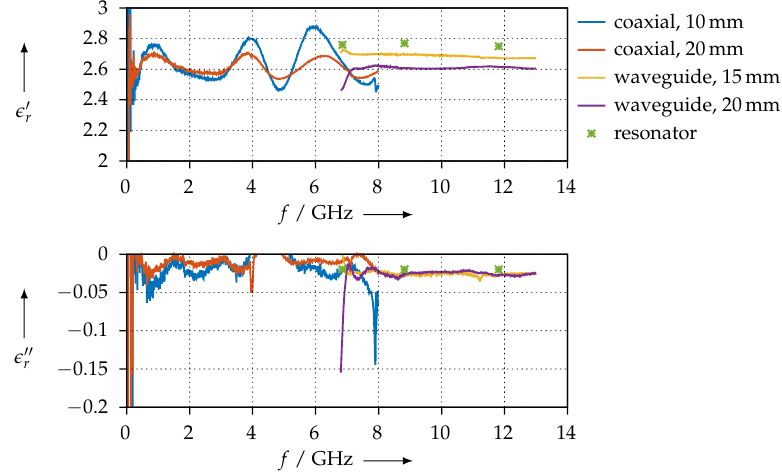
Figure 20. Real ( (cid:101) (cid:48) r ) and imaginary ( (cid:101) (cid:48)(cid:48) r ) parts of the permittivity for the PLA